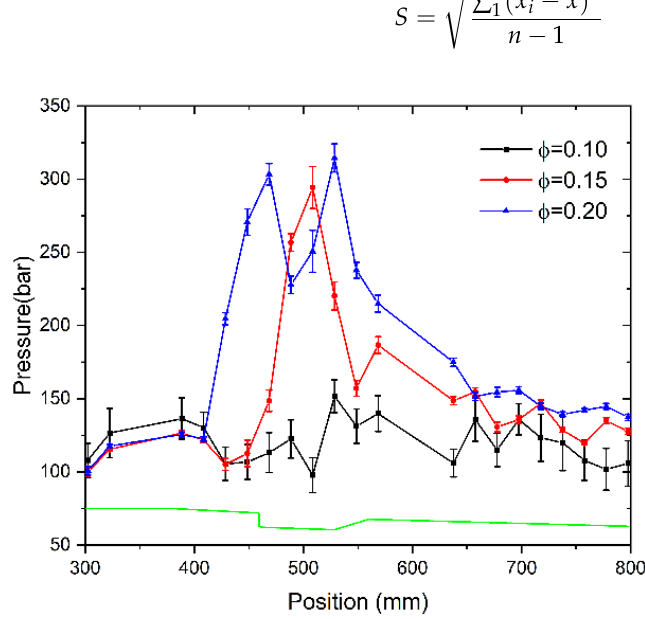
Figure 3. Static pressure for various equivalence ratios along the scramjet combustor.